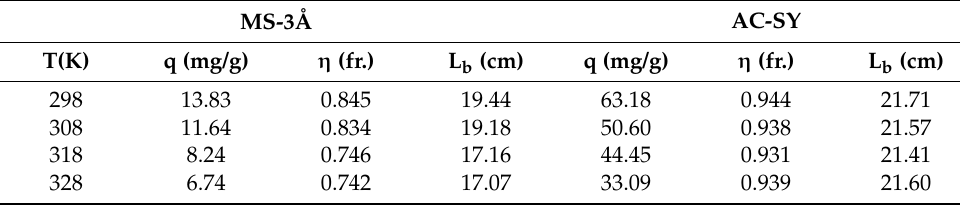
Table 3. Adsorption characterizations at different temperatures (F = 4 lpm, C in =